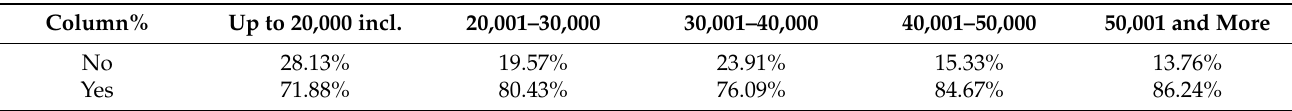
Table 5. Columnar relative frequencies (variables online organic food purchases and net monthly family income), in CZK.